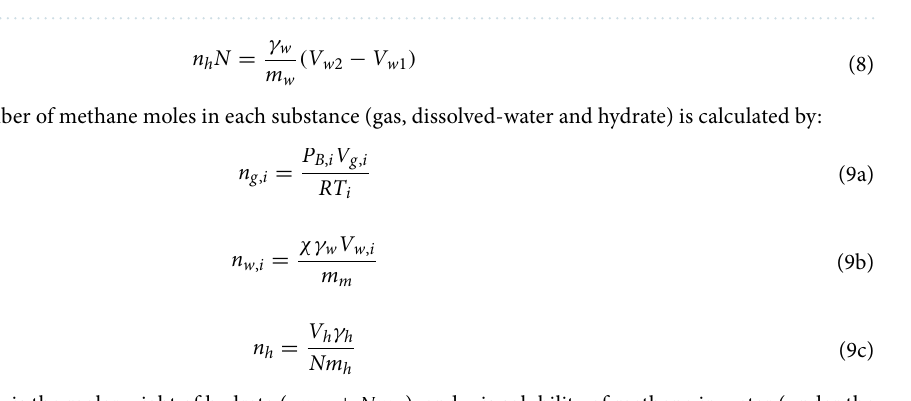
Figure 7. ( a ) Comparison between the three S h calculation methods as a function of the initial water content, ω , and ( b ) the maximum deviatoric stress, q max , as a function of three calculated S h